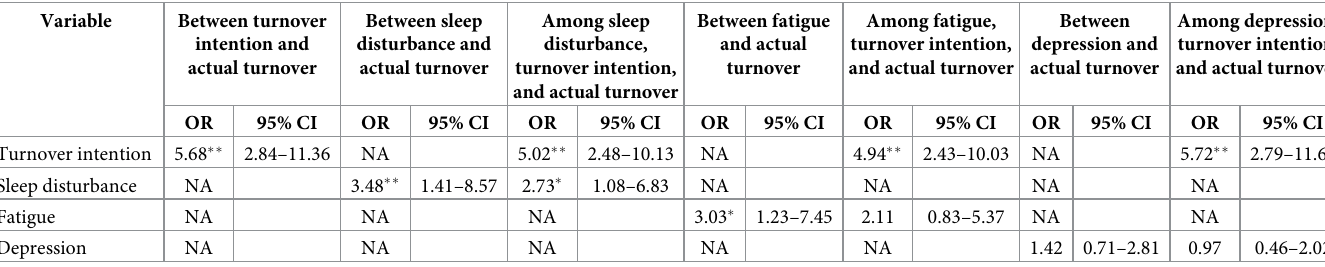
Table 3. Associations between health problems and actual turnover according to the multiple logistic model.